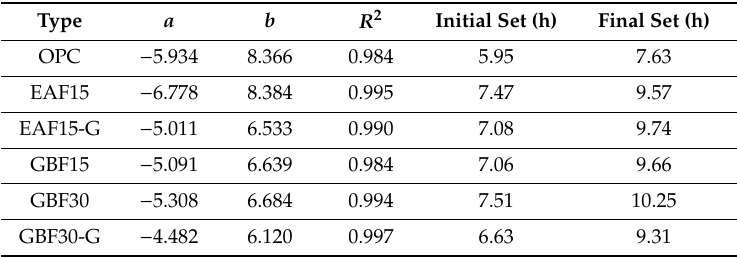
Table 4. Results of initial and final